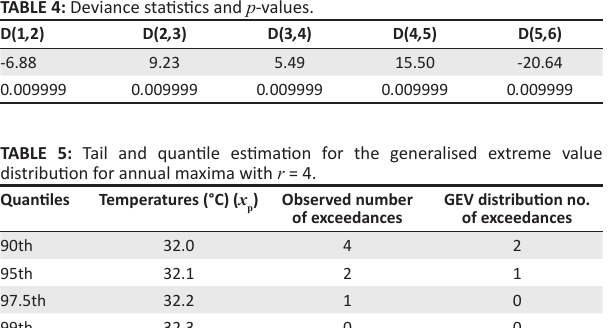
GEV, generalised extreme value.